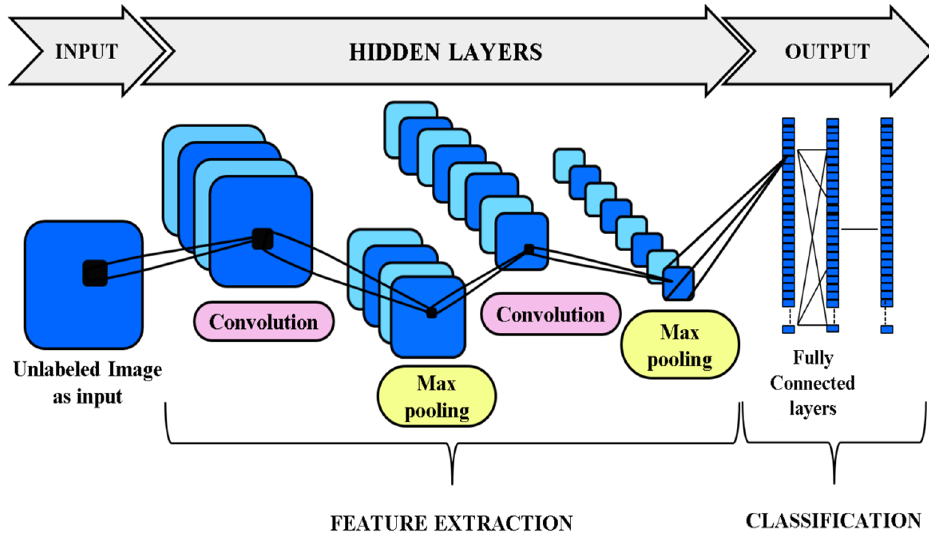
Figure 4. Working on a basic CNN model.